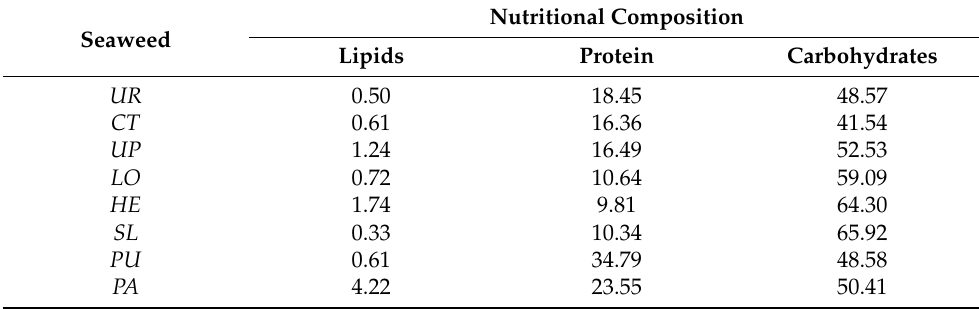
Table 1. Nutritional composition of the studied seaweeds (g/100 g dry weight). Seaweed